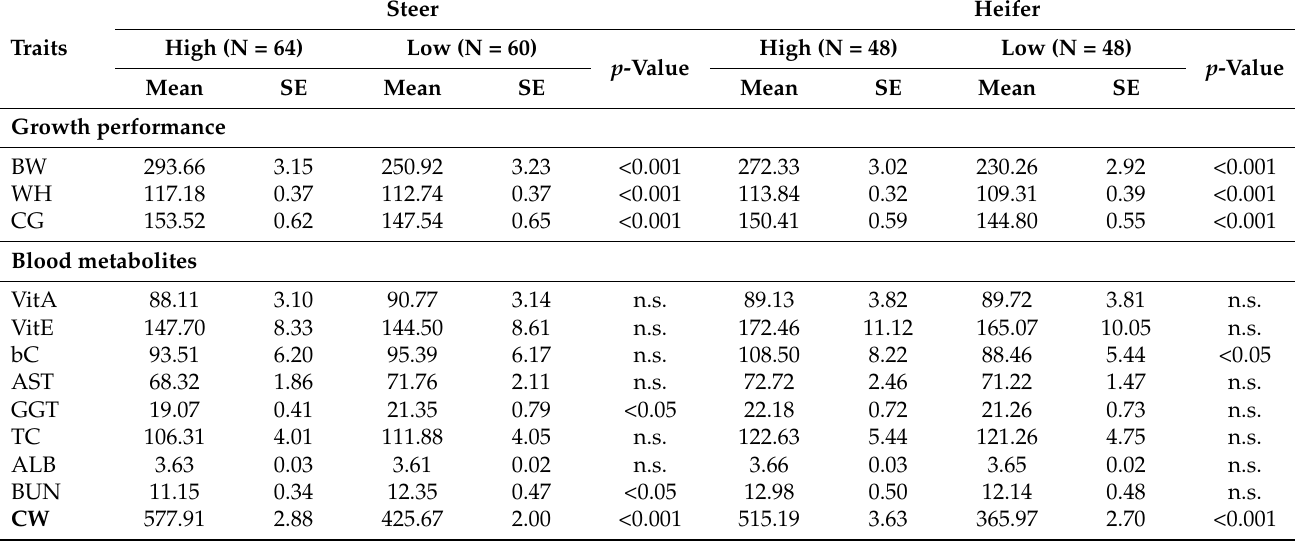
Table 3. Comparisons of growth performance, blood metabolites, and carcass weight between high and low carcass weight (CW) groups. Growth performance and blood metabolites were measured at the start of fattening (approximately 8–10 months). SE: Standard error. Abbreviations of traits are shown in Table